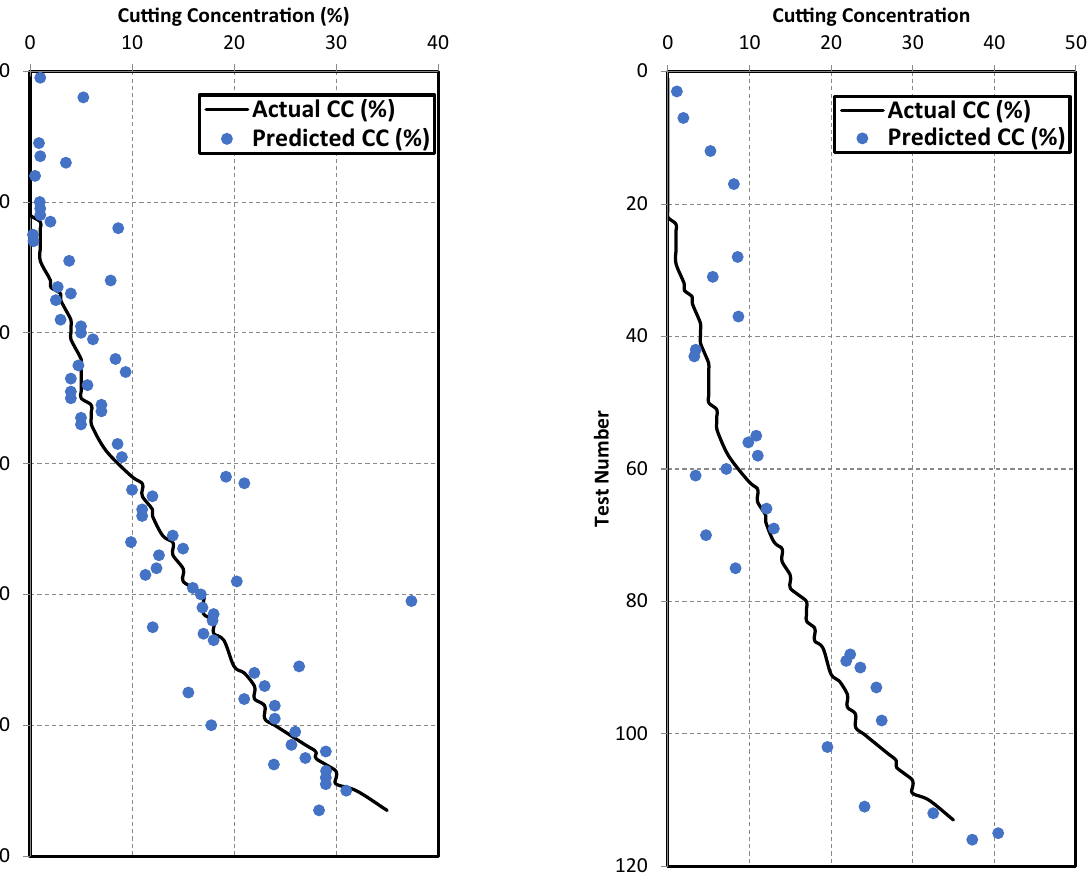
Fig. 14 Actual (experimental) and SVM-predicted cutting concentra- tion versus test number from testing stage